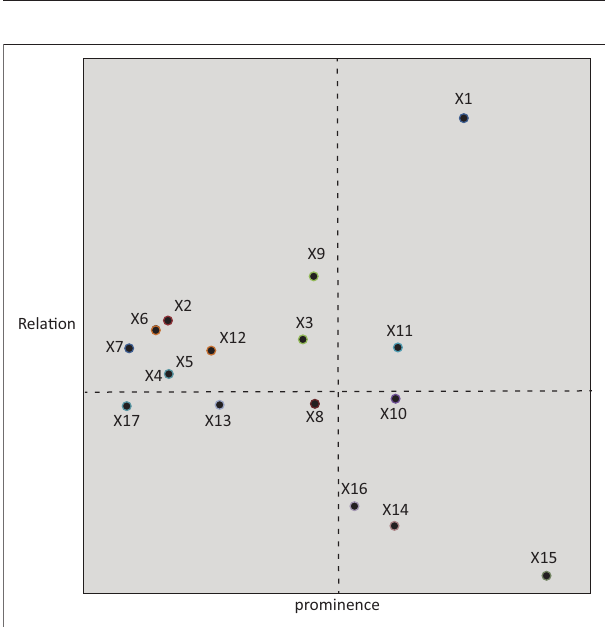
FIGURE 5: 2D causal diagram.